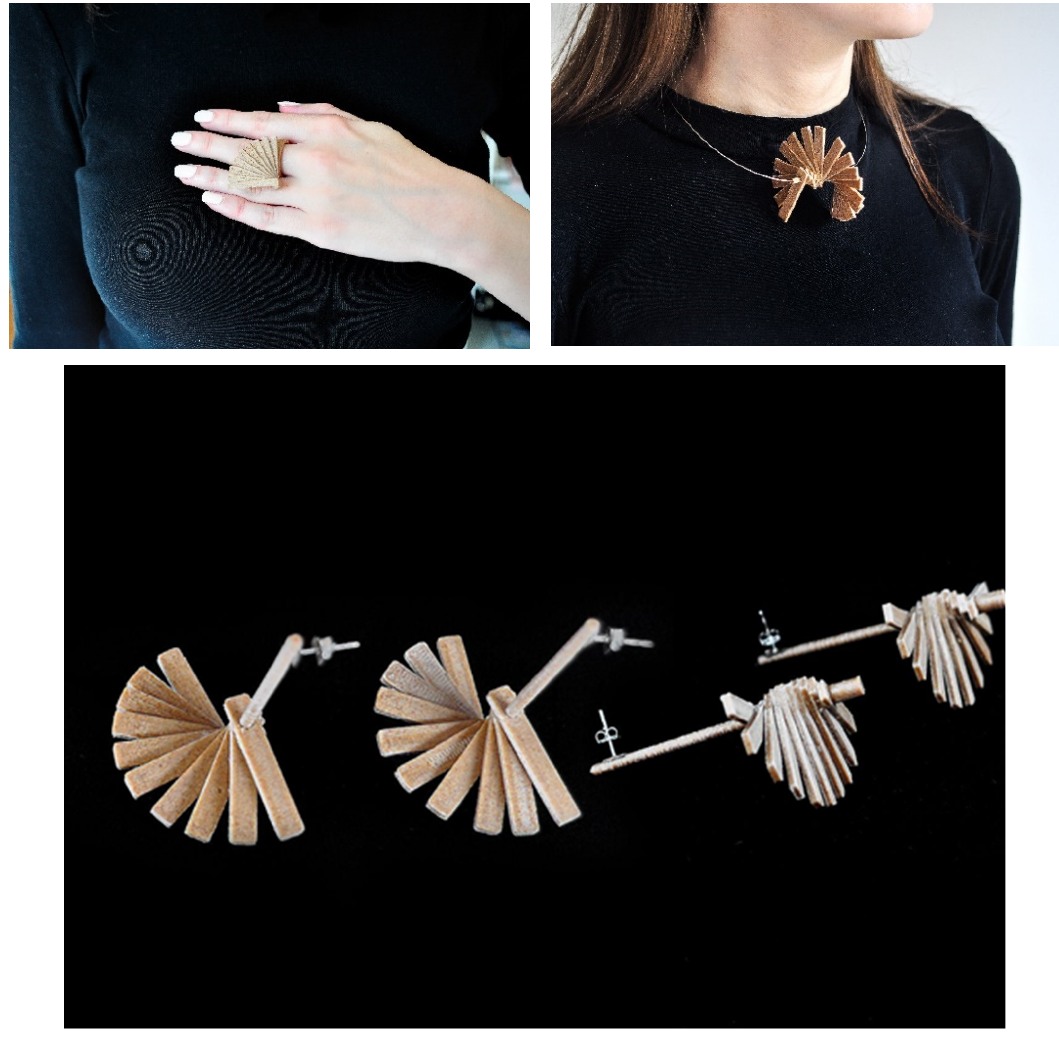
Figure 13. Collection of jewellery printed with polymer containing recycled wood (author: Katrin Ve č erina).